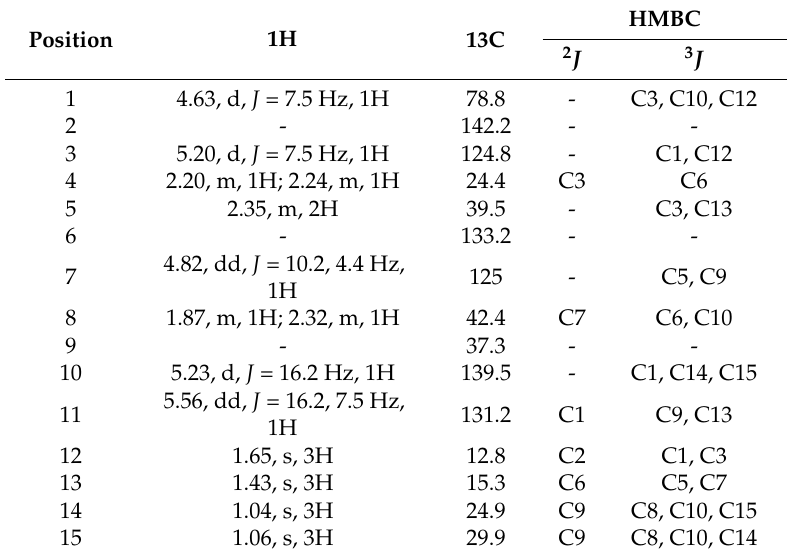
Figure 1. Chemical structures of terpenes isolated from Z. montanum . Table 3. 1 H- (600 MHz) and 13 C- (150 MHz) NMR and HMBC (500 MHz) data of 2 in CDCl 3.